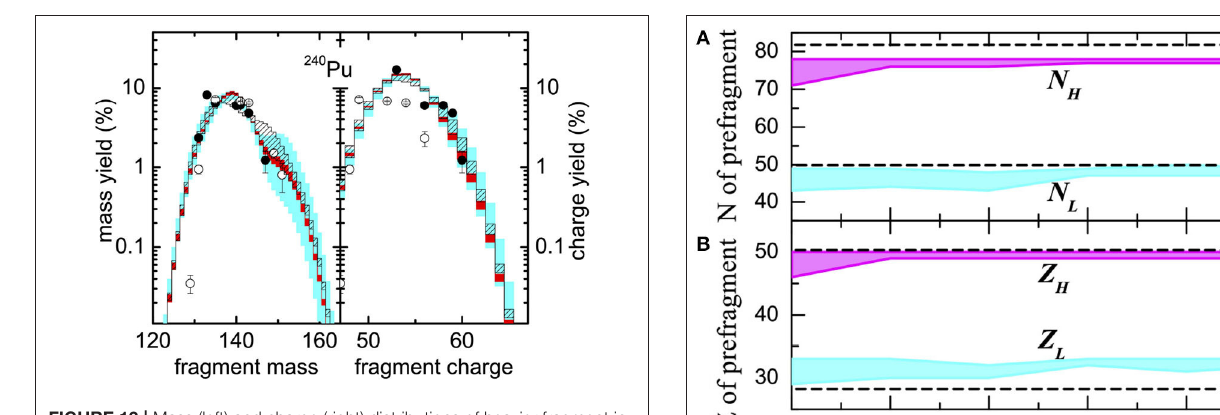
FIGURE 12 | Mass (left) and charge (right) distributions of heavier fragment in the SF of 240 Pu. The symbols are experimental values as shown in Figure 10 . The shaded regions describe uncertainties in the yield distributions corresponding to different values of the model parameters: E 0 (narrow red band), dissipation tensor (wider cyan band), and scission configuration (linear hatch pattern). See Sadhukhan et al. [ 29] for details. The figure is adapted from Sadhukhan et al. [29].